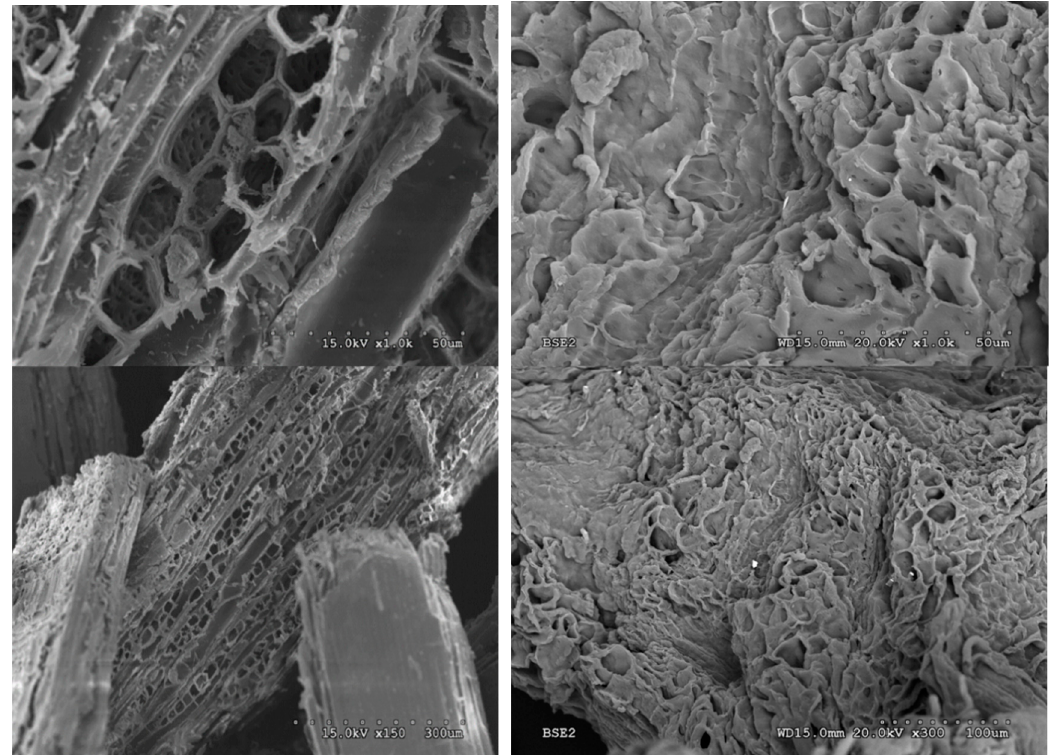
Figure 11. Scanning electron microscopy (SEM) images of raw barley straw ( left ) and barley straw treated with [EMIMAcO] (Solid I, WA 1:1) ( right ).